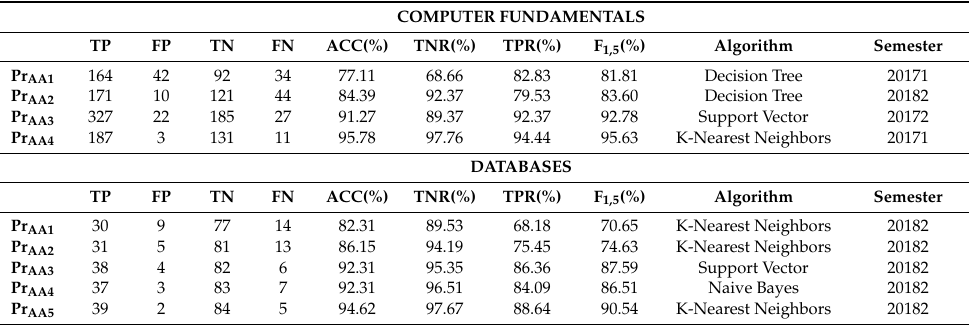
Table 4. Performance of the GAR